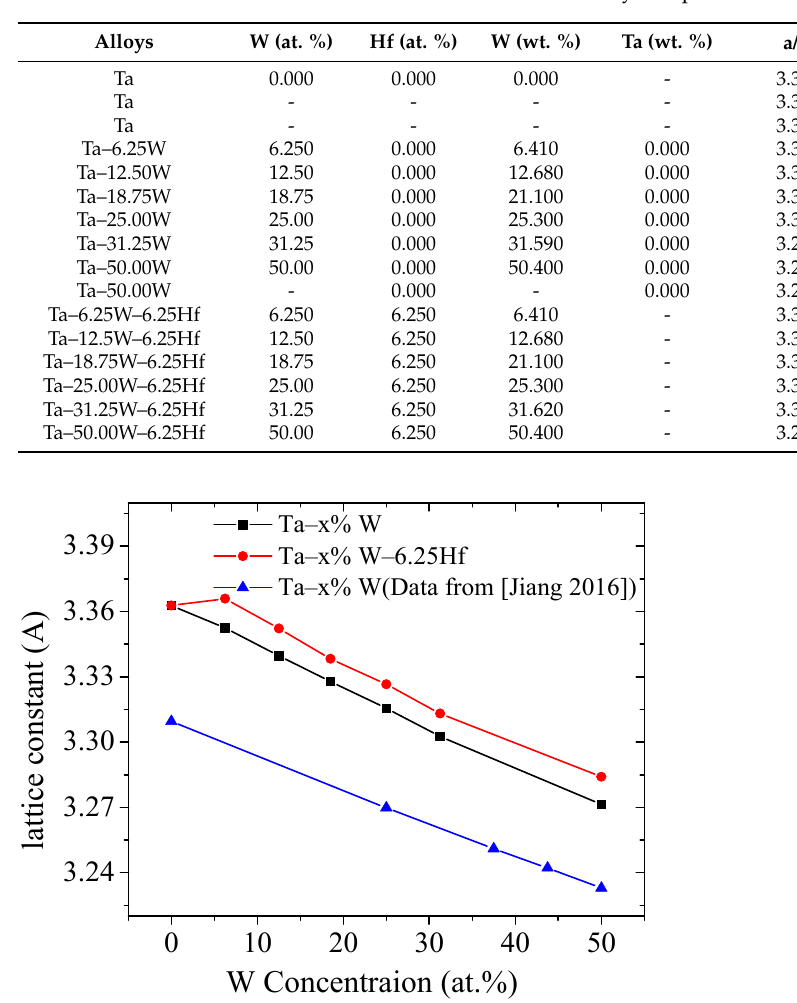
Figure 3. Relationships between the lattice constant and W content of Ta–W alloys. Data from Jiang [23] .